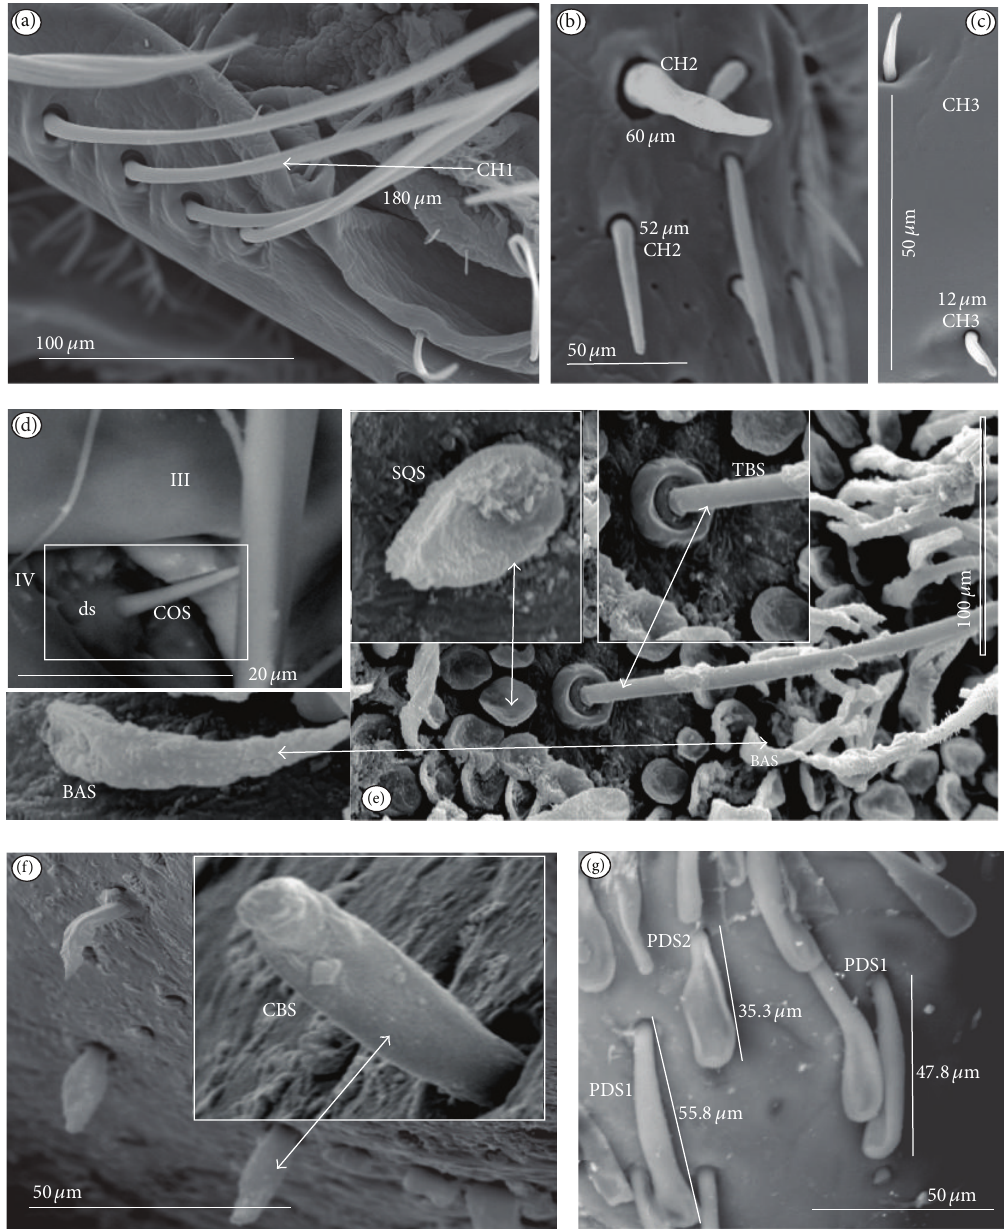
Figure 1: Types and sizes of the mechanosensilla of the Nepomorpha. (a) CH1 chaetic sensillum, long. (b) CH2 chaetic sensillum, medium length. (c) CH3 chaetic sensillum, short. (d) COS conical sensillum (prioprereceptive). (e) SQS squamiform sensillum, TBS trichobothrium sensillum, and BAS basiconic sensillum. (f) CBS clubbed-like sensillum. (g) PDS1 paddle-like sensillum, long, PDS2 paddle-like sensillum,